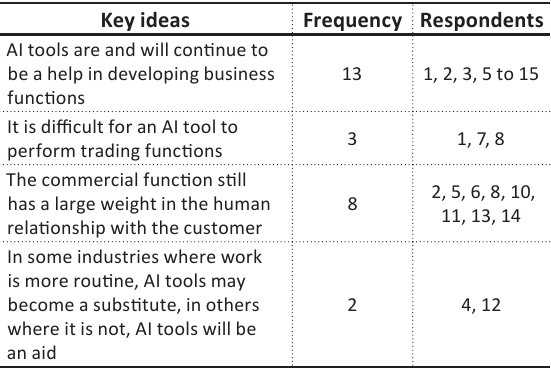
Table 3. Commercial perspective about